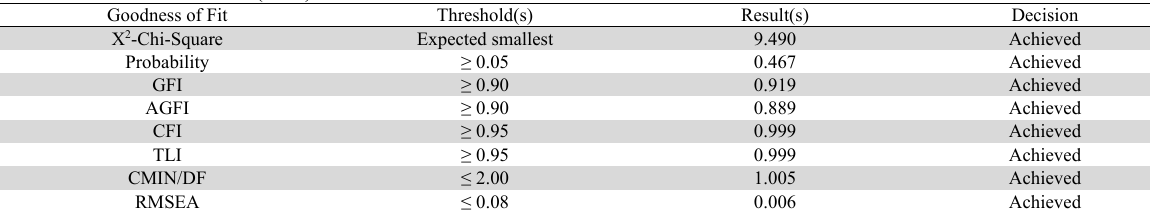
Results of hypotheses testing for direct effect